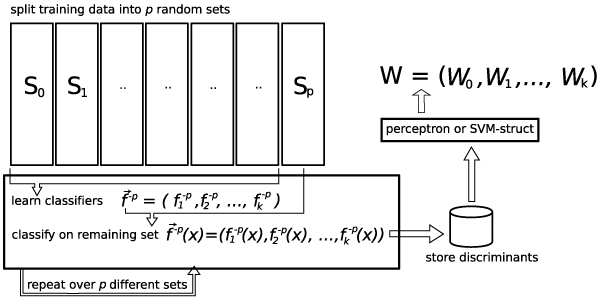
Summary of the main stages of the adaptive code methodology for multi-class protein classification. The figure gives an overview of the training workflow for the adaptive codes method. The box for learning weights is illustrated in detail in Figure 3.